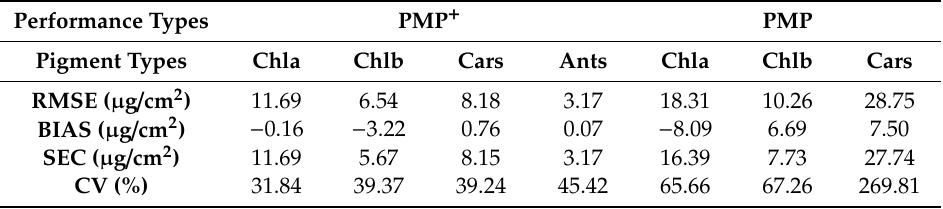
Table 5. The validation of pigment content retrievals from in vivo leaf spectra by PROSPECT-MP+ (PMP+) and PROSPECT-MP (PMP) (leaf sample number m = 28). The metrics RMSE, BIAS, SEC and CV are Root Mean Square Error, Bias, Standard Error Corrected and Coefficient Variability for the errors between the measured and retrieved content s of leaf pigment, respectively.